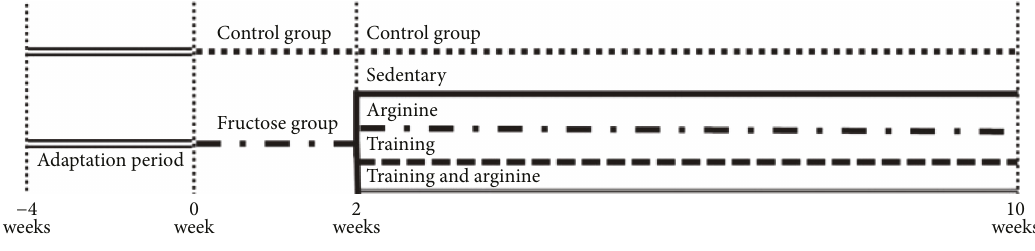
Figure 1: Experimental protocol. Table 1: Nutritional information of Nuvilab Cr-1 commercial